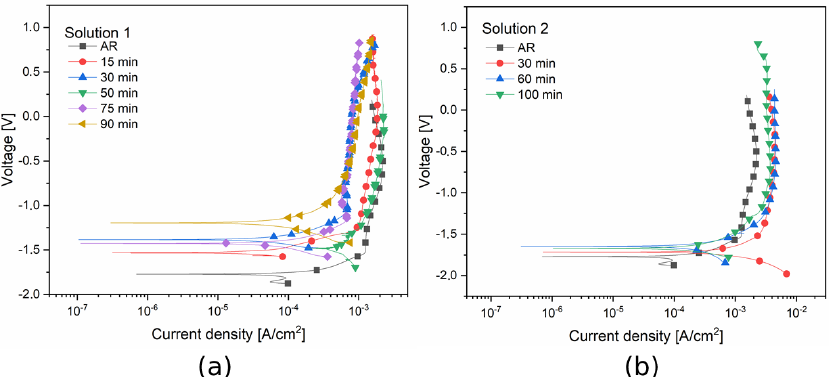
Figure 11. Potentiodynamic polarization curves for the samples treated in solution 1 at 50 °C ( a ) and for the samples treated in solution 2 at ambient temperature ( b ). Test electrolyte: commercial solution that simulates cleaning product •. Table 4. Corrosion potential and corrosion current densities extrapolated from the potentiody- namic polarization plots reported in Figure 11a for the samples obtained with solution 1 at 50 °C.